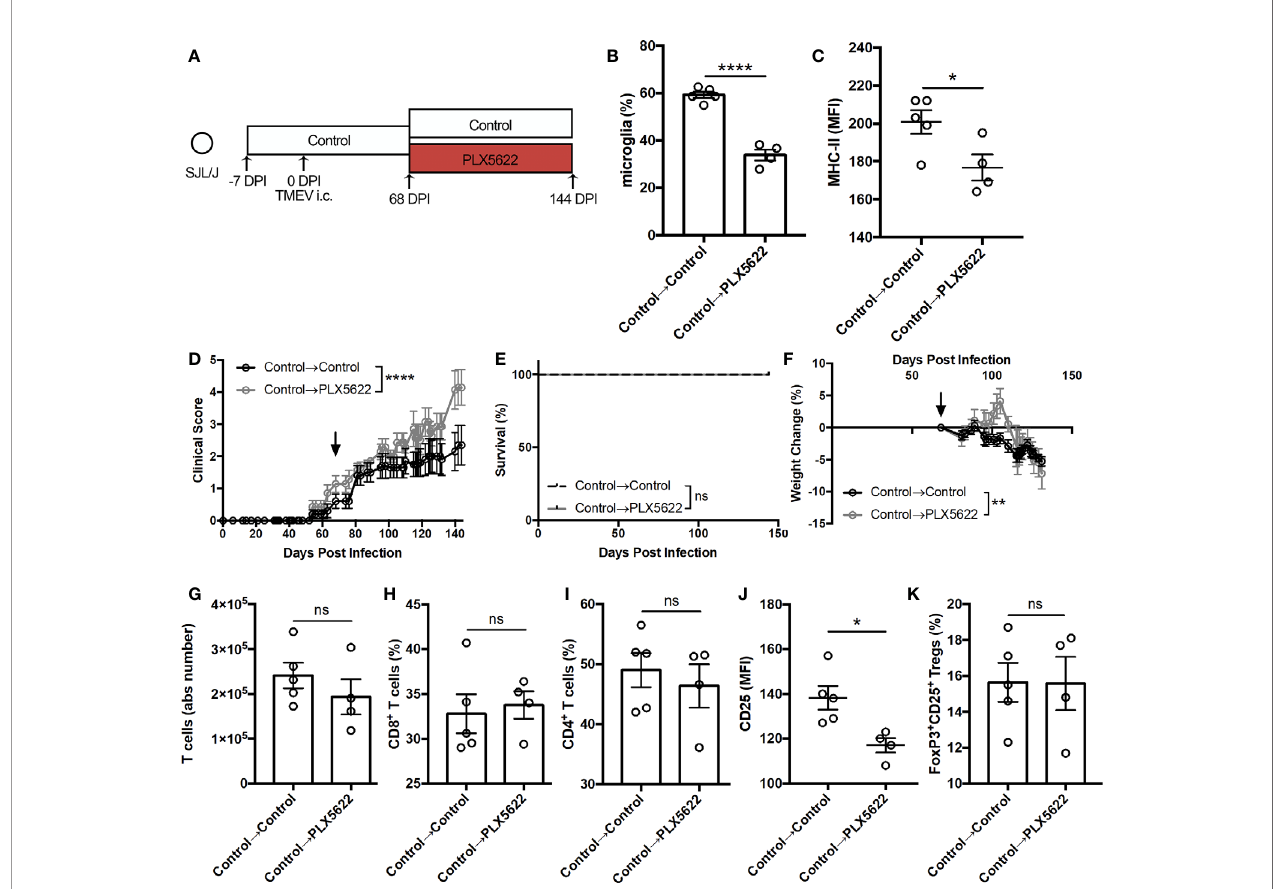
FIGURE 7 | Initiating PLX5622 during chronic TMEV infection exacerbates clinical score while maintaining T cell in fi ltration. (A) SJL/J mice were treated with a control diet seven days prior to i.c. TMEV infection, switched to a PLX5622-supplemented diet or remained on the control diet at 68 DPI, and were sacri fi ced at 144 DPI for analysis. (B) Proportion and (C) MHC-II expression of microglia. (D) Clinical score, (E) survival, and (F) weight change corresponding to (A) (n = 7-10 mice per group). (G) Number of CNS T cells. Proportion of (H) CD8 + T cells and (I) CD4 + T cells of CNS CD3 + T cells. (J) CD25 expression in CNS CD4 + FoxP3 - T cells. (K) Proportion of CD4 + FoxP3 + CD25 + Tregs of CNS CD4 + T cells. Data are presented as mean ± SEM with 4-5 mice per group for (B) . (C, G – K) . *P ≤ 0.05, **P ≤ 0.01; ****P ≤ 0.0001, ns, not signi fi cant. Student t test for (B, C , G – K) , log-rank test for (E) , and two-way ANOVA for (D, F)